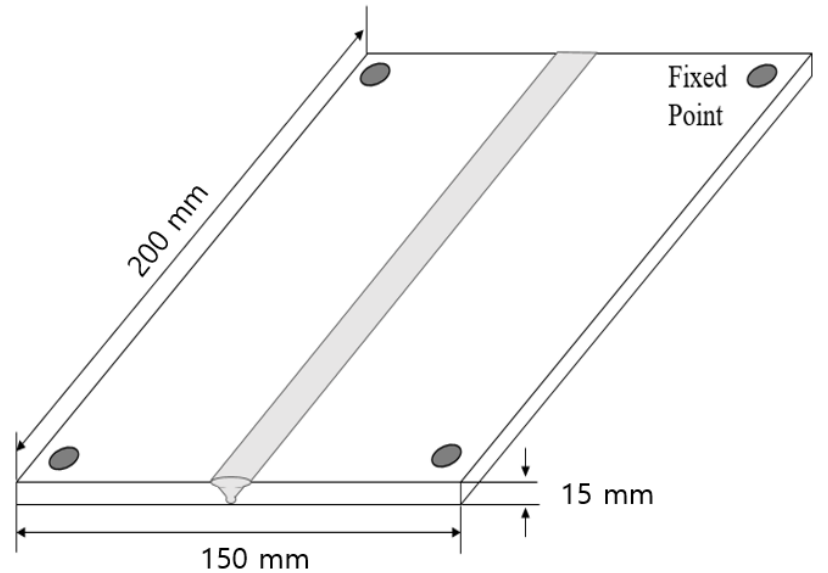
Figure 1. Schematic diagram of the welding specimen and constraints.